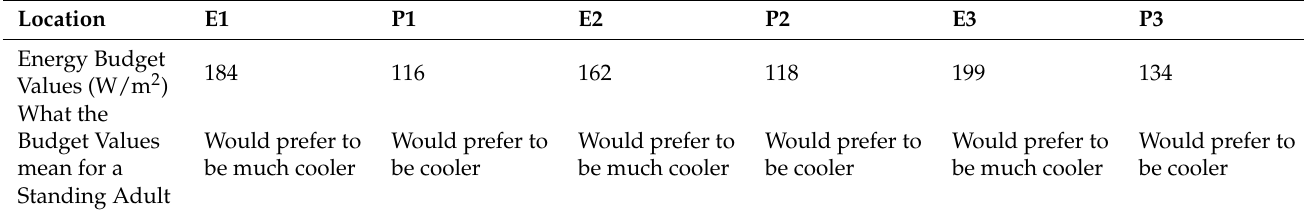
Table 4. COMFA models